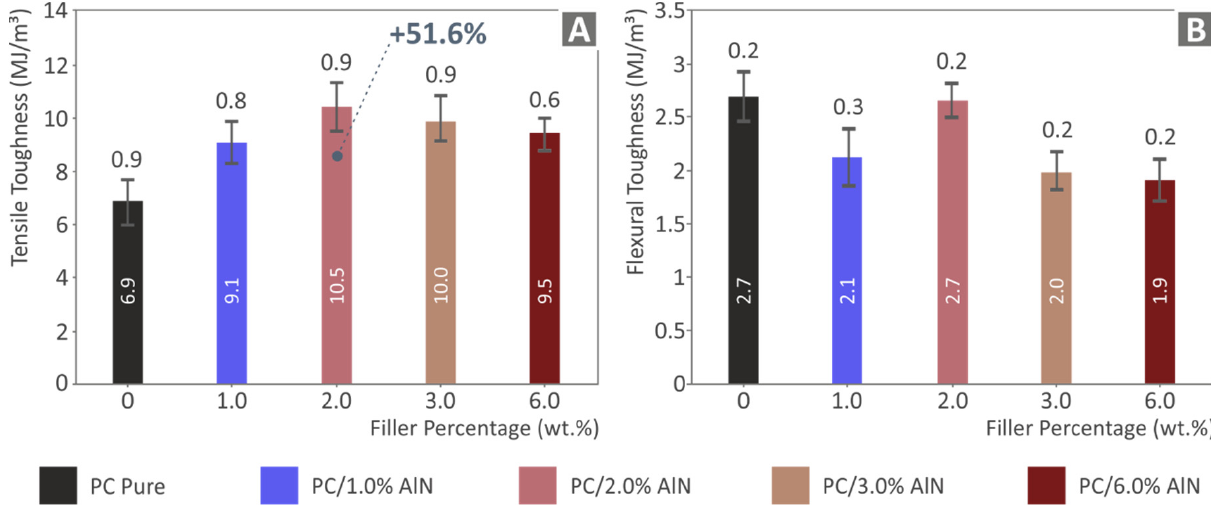
Figure 11. ( A ) Tensile toughness results (average value and deviation), ( B ) flexural toughness results (average value and deviation) of the five tested specimens.